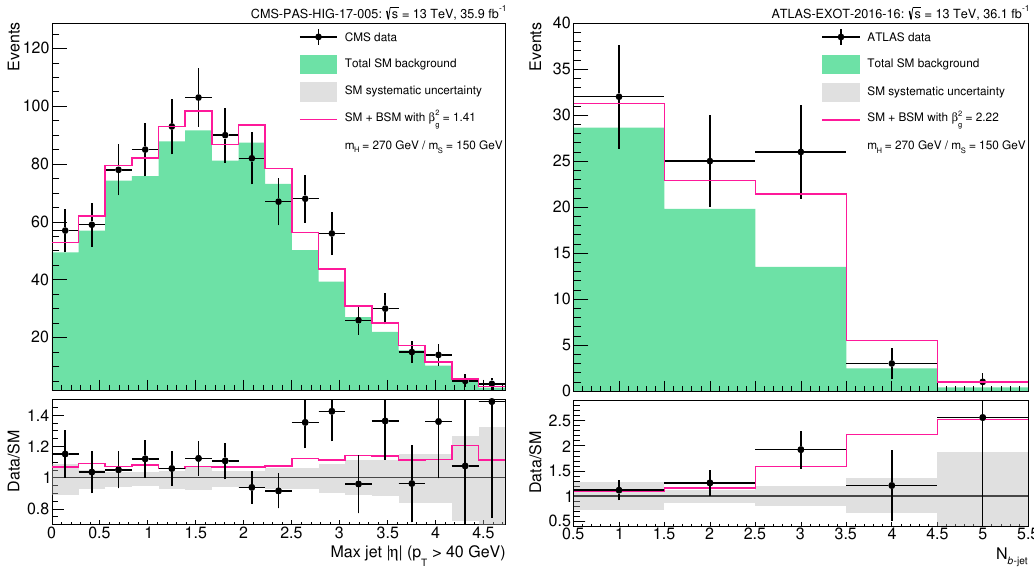
Figure 5 . The SM+BSM (cid:12)t results applied to searches for SS leptons in association with b -jets in the CMS (left) and ATLAS (right) Run 2 data sets. The discriminating variables in the (cid:12)t are the highest value of pseudo-rapidity for high p T jets in the CMS search and the b -jet multiplicity in the ATLAS search. In each case, (cid:12) 2 has been scaled to its best-(cid:12)t value, while the SM predictions are g shown at their nominal values without any (cid:12)t constraints. The systematic uncertainties are shown as bin-by-bin e(cid:11)ects, as reported by the experimental collaborations. However, in the (cid:12)t an overall normalisation systematic uncertainty is considered for each